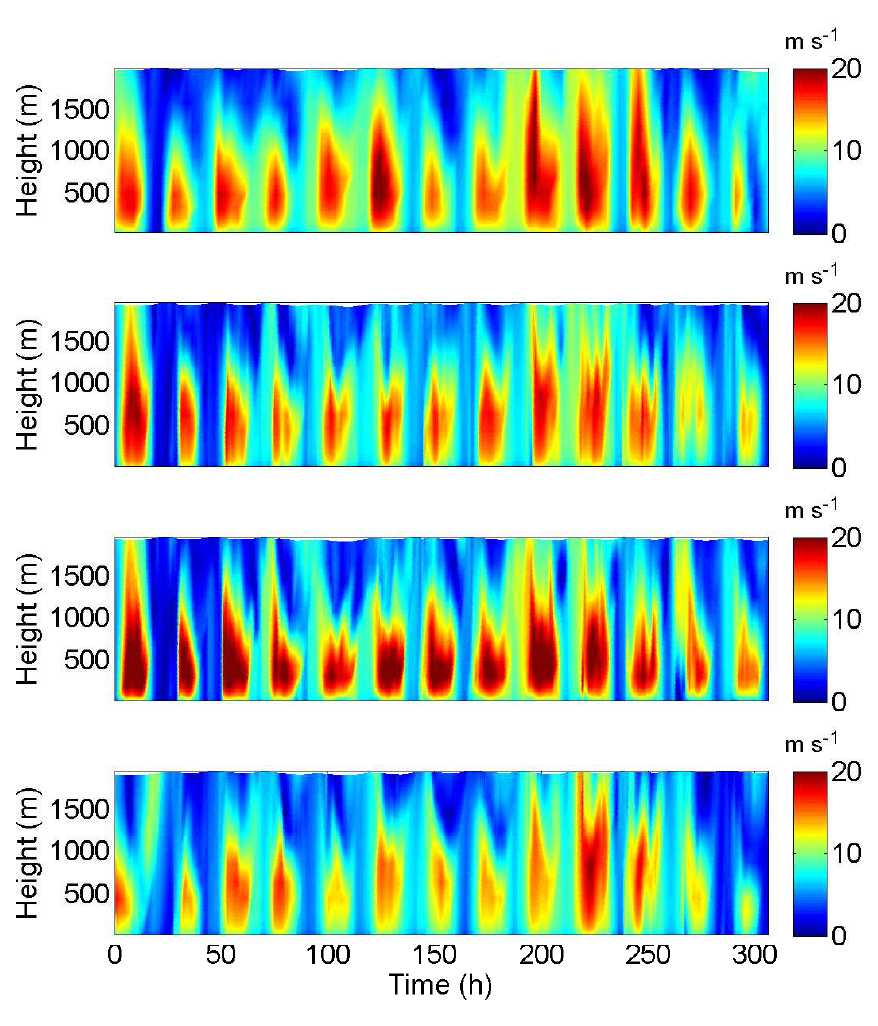
Figure 3. Time-height plots of mean wind speed between May 19, 2006 and May 31, 2006. The panels represent (from top to bottom) WRF-NCAR, WRF-YSU-NARR, WRF-MYJ-NARR, and WRF-YSU-AWIP runs, respectively. Occurrences of low-level jets are clearly visible in all the model